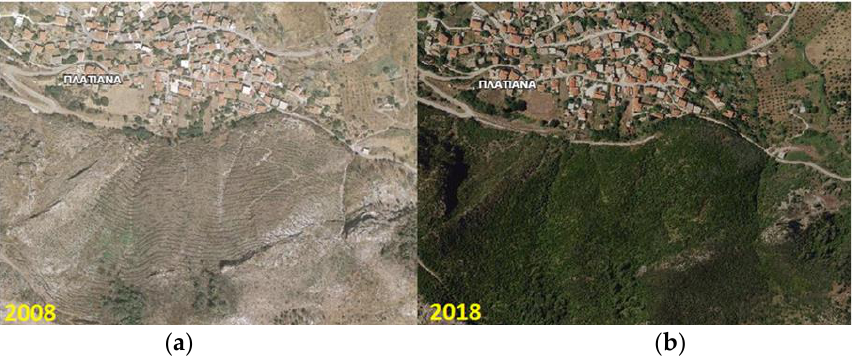
Figure 7. Slope profiles used RocFall analysis regarding Platiana region. The slope picture is taken from Greek Cadastral (2008). Table 4. Geological and material characteristics.